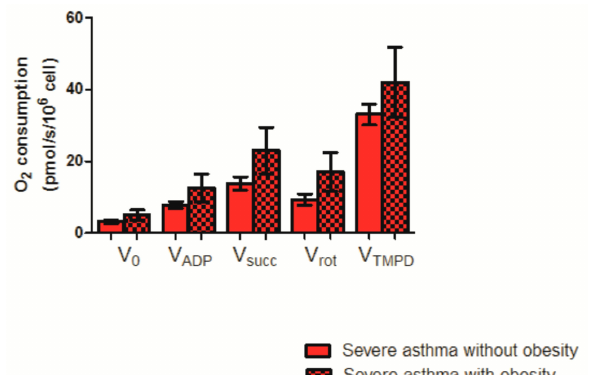
Figure 3. PBMC mitochondrial respiration in severe asthmatic patients, without or with a BMI ≥ 30 kg / m 2